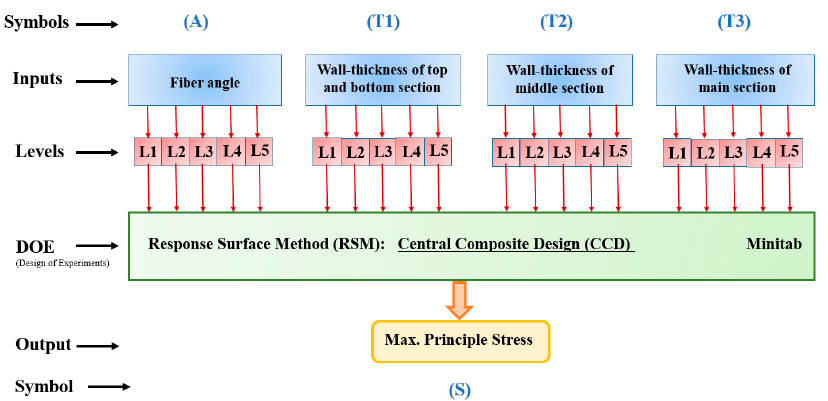
Figure 6. The schematic of the response surface method (RSM)-based design of experiments used in this study. After analyzing the data by RSM [20–22] to investigate the effect of parameters (wall-thickness of composite shell in three different sections of the CNG tank and the fi- ber angle) on the response (maximum principle stress), the optimization tool was used to reduce stress in the critical region of the structure and the optimum values for the pa- rameters were extracted. Since there is a direct relationship between the fatigue life of the component and stress, the optimum tank is expected to have a maximum fatigue life. 5. Results and Discussion Explicit transient dynamics analysis was performed and the stress tensor compo- nents were extracted in terms of time. The small time increments were considered for the convergence of the solution, then, the time history of principal stress was obtained as the FE response [26–28] for all cases proposed by RSM. Next, the maximum value in each history was considered as the output in the response surface method (Table 4). To facili- tate the analysis by the response surface method, the response values are always con- sidered positive [29]. Also, the principal stress contour in the CNG tank concerning the values of parameters provided by the manufacturer (initial design) is demonstrated in Figure 7. According to the results of the FE analysis, the highest absolute principle stress (S = 206.32 MPa) is related to the joint area of the composite shell to the flange, which is consistent with the results presented by Nouri et al. [5]. Then, the bonding area between the composite layers in the two parts of the main body and the spherical curvature is critical. Therefore, these two regions in the composite CNG tank are identified as critical areas that are apt to fail and future analysis will be carried out to estimate fatigue life only in the critical elements of these two areas. Table 4. Finite element results for the different settings of wall-thickness parameters and fiber an- gle based on the RSM. Simulation No. Level of Input Parameters